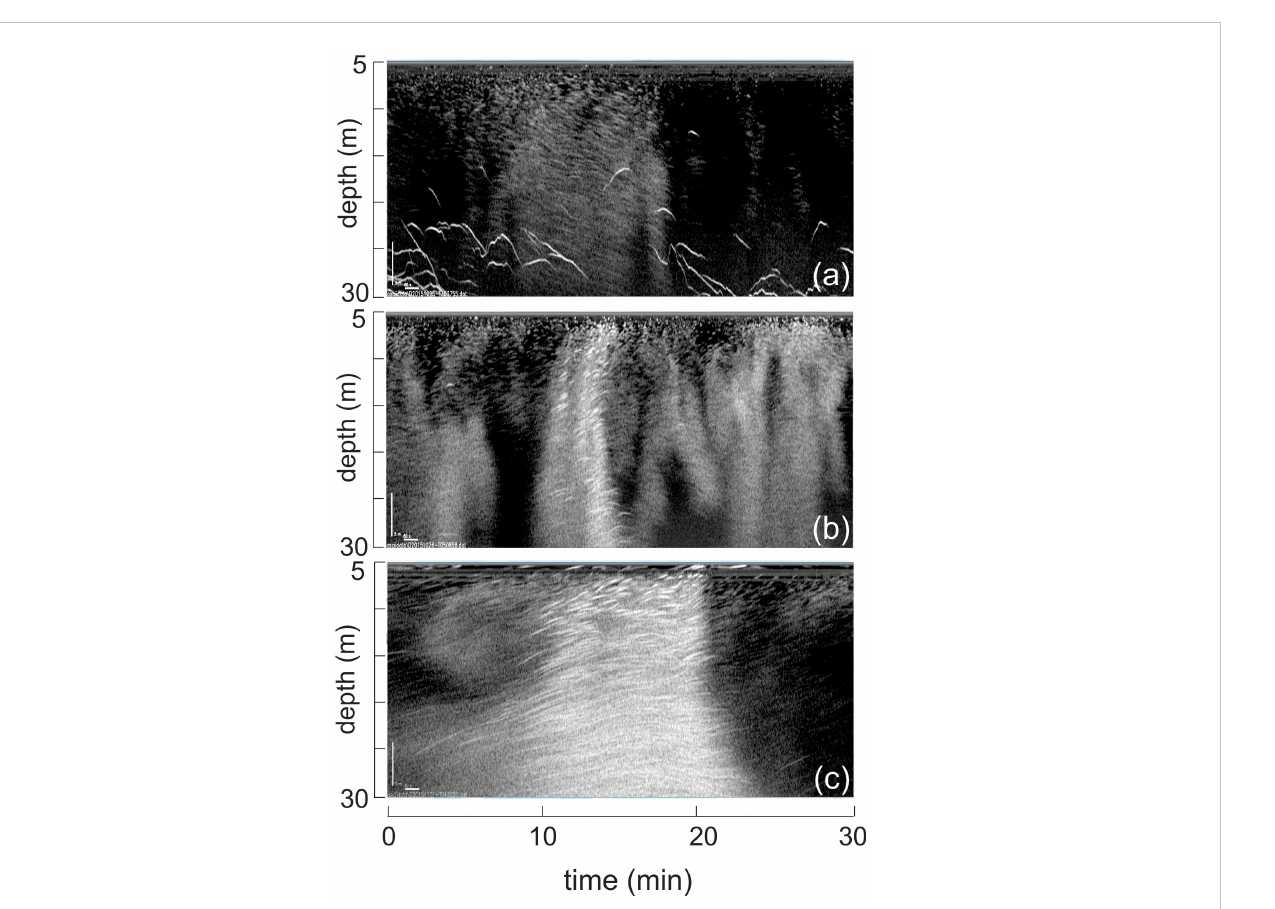
FIGURE 7 acoustic sounder images from different times. These images capture platelets as well as biological back-scatterers. A diagonal corner-to-corner path represents a rise speed of 14 mm s -1 . The segments come from (A) 25oct2015 at 1528 UTC (DOY 298.65), (B) 26oct2015 UTC at 0509 (DOY 299.84) and (C) 1nov2015 0438 UTC